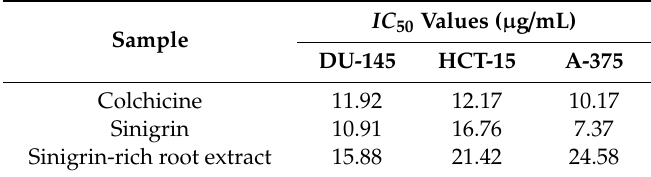
Table 4. IC 50 values of sinigrin and prepared R. sativus roots fractions of on DU-145, HCT-15, and A-375 cell lines.